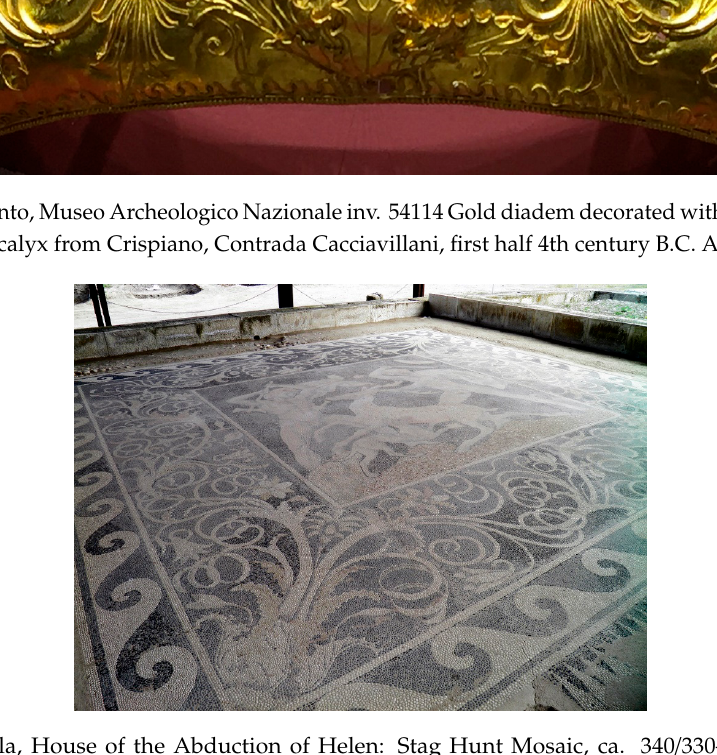
Figure 9. Pella, House of the Abduction of Helen: Stag Hunt Mosaic, ca. 340/330—320/310 B.C. Author’s photo.